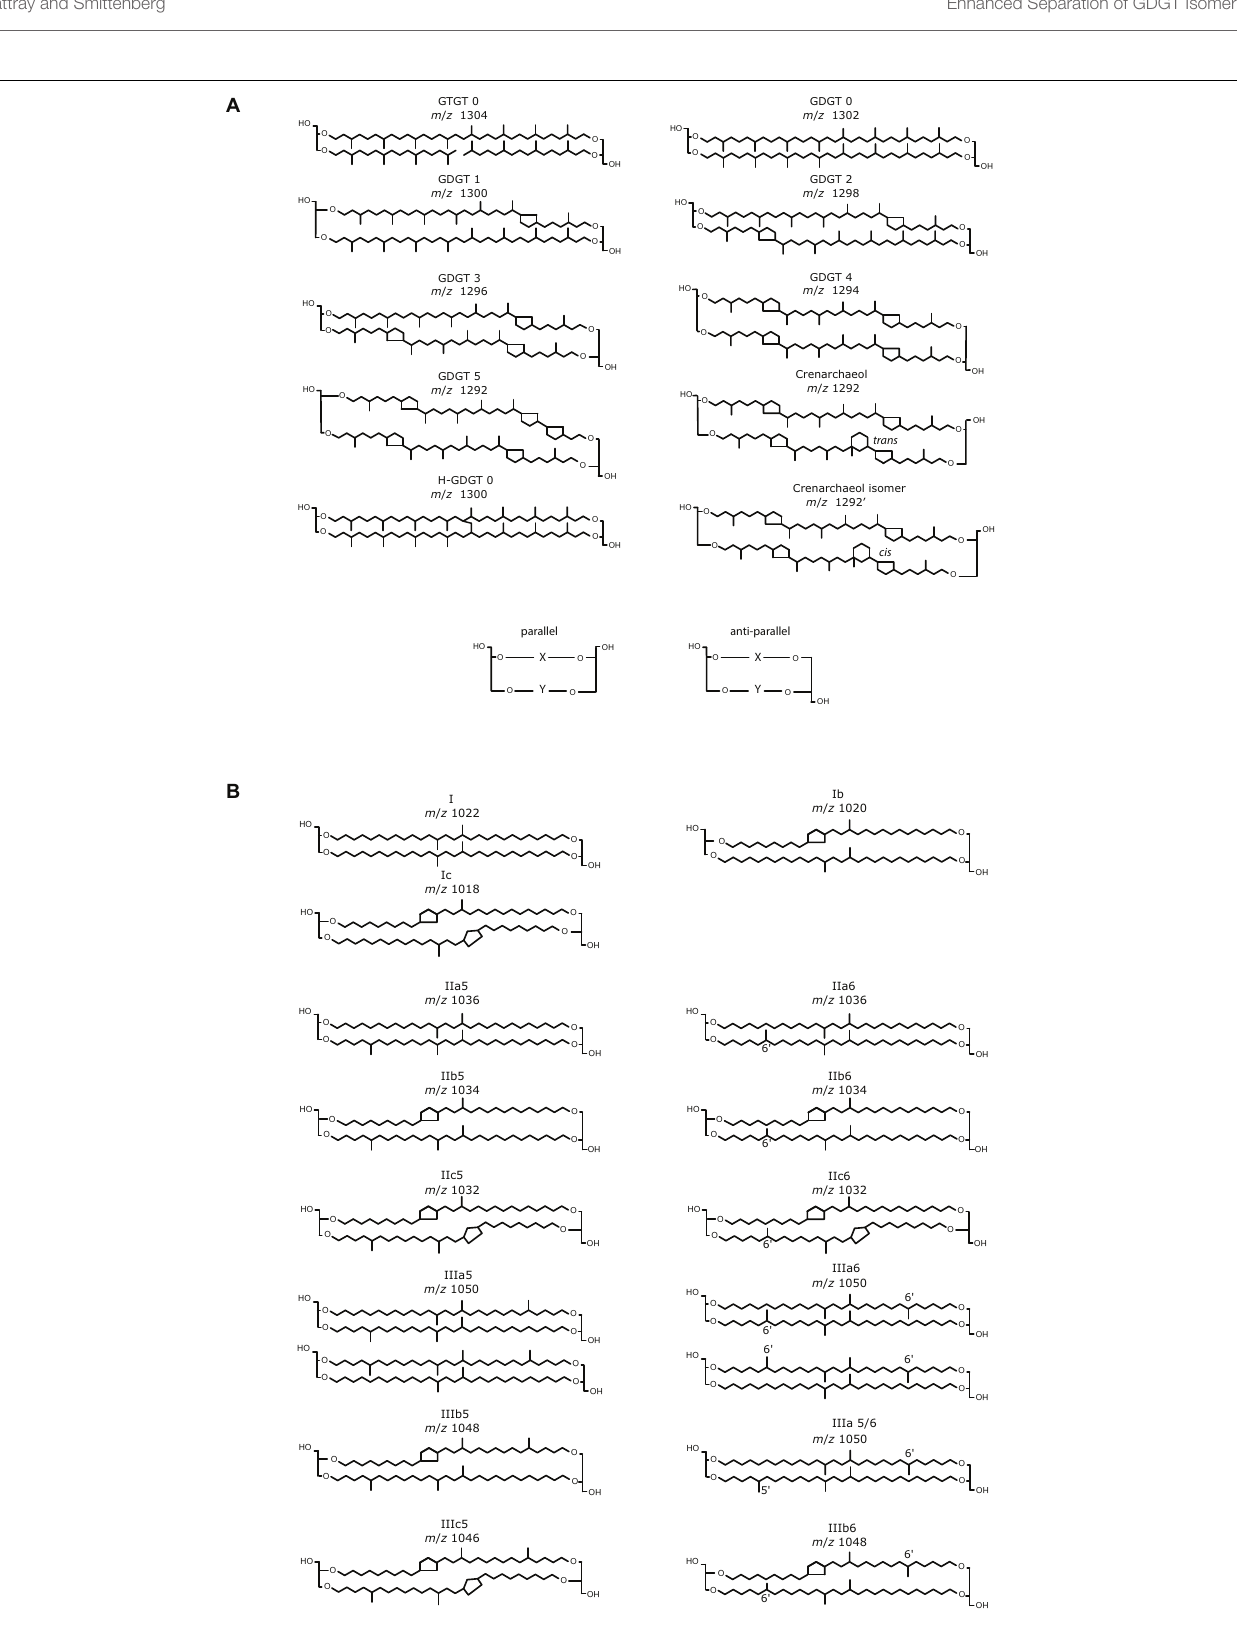
Frontiers in Marine Science |